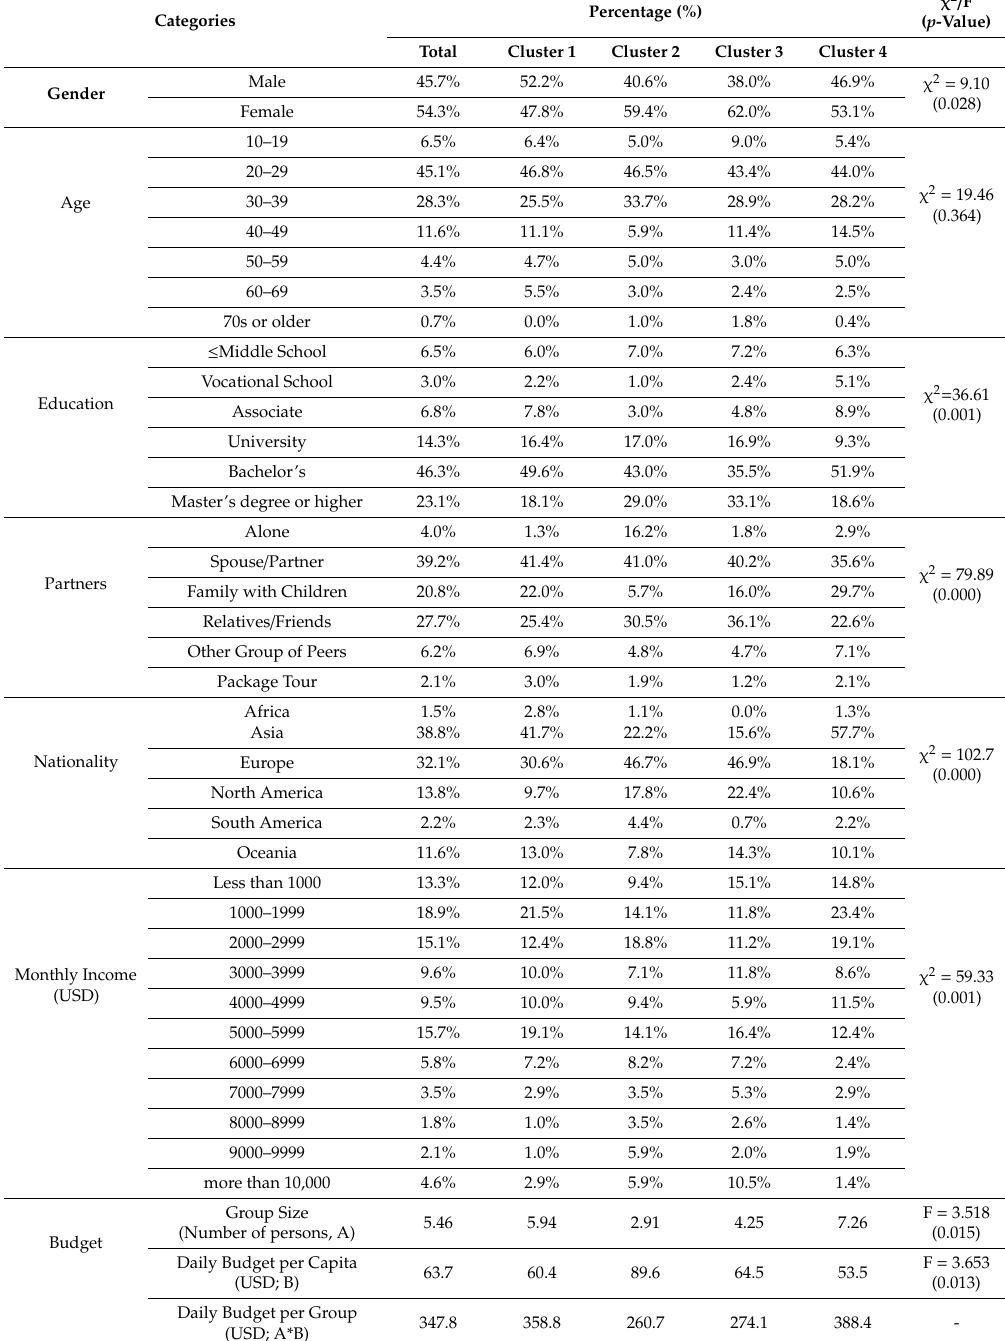
Table 7. Cluster profiling and comparison: demographic